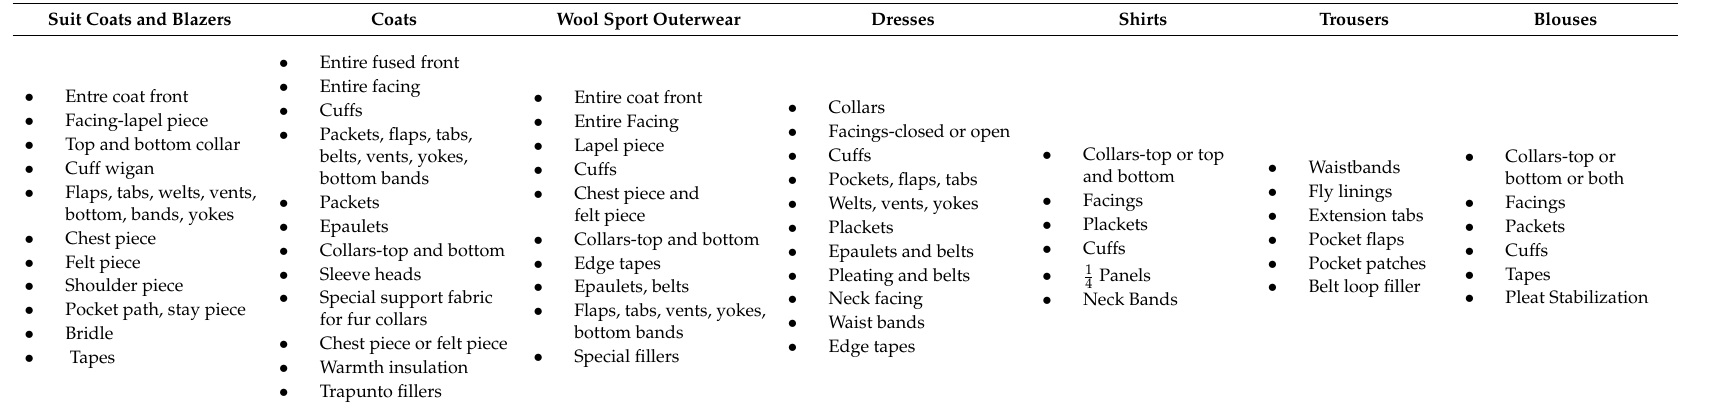
Table 5. Summary of application for